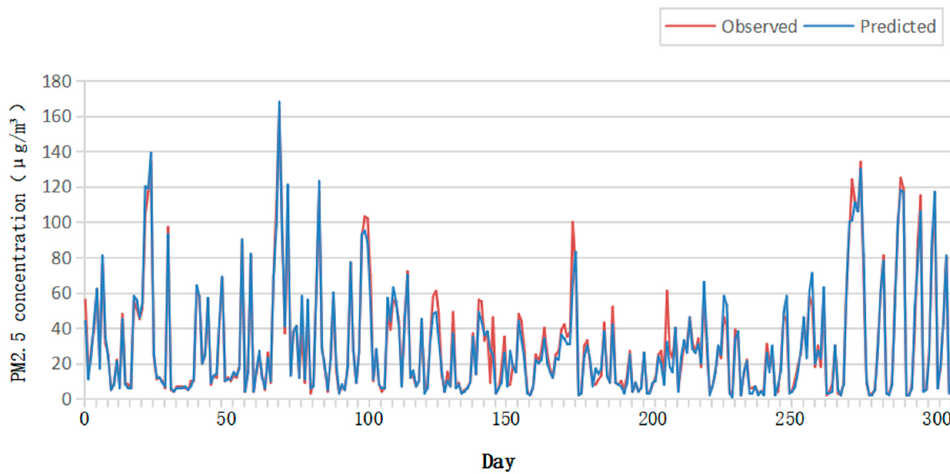
Figure 6. The comparison of observed and predicted values from January to October 2022.